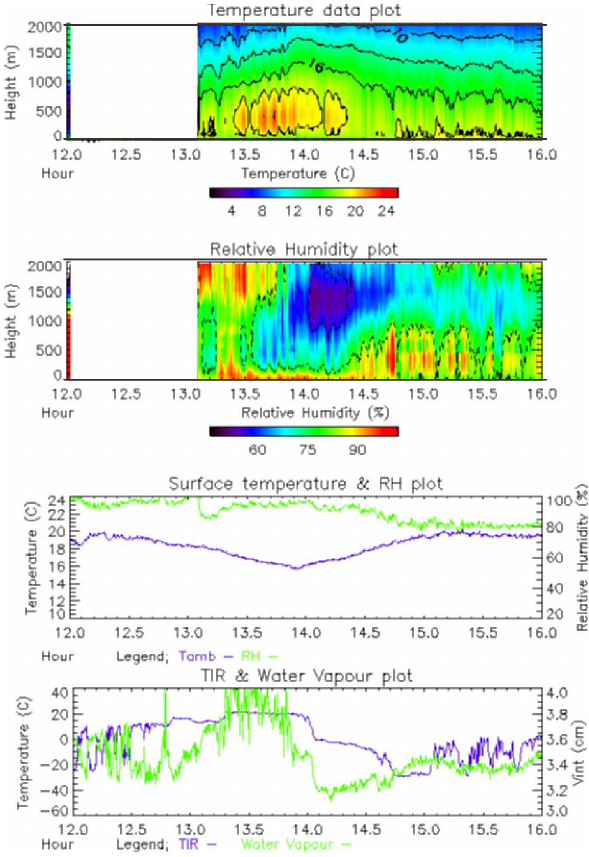
Fig. 7. Microwave radiometer retrieval showing temperature, rel- ative humidity and for 0–2km height, 24 June 2005, 12:00– 16:00UTC. Radiometer calibration in error from 12:00 to 13:00, and radiometer measurements should be ignored in this period. Time series of scalars are also shown surface temperature and sur- face relative humidity, infrared brightness temperature, and inte- grated water